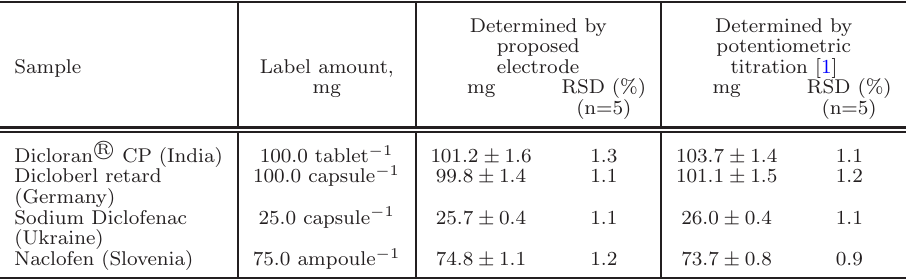
Table 4 Diclofenac quantities in actual samples determined using the proposed membrane electrode and potentiometric titration